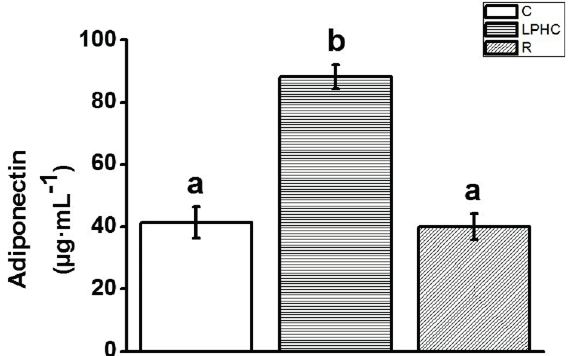
Figure 3 - Serum adiponectin levels in rats fed a control diet for 45 days (C ), a low-protein, high-carbohydrate (LPHC) 45 diet for 45 days or an LPHC diet for 15 days followed by a control diet for 30 days (R). Results are expressed as means ± standard errors of the means across eight animals per group. Statistical analysis was performed using ANOVA (one-way ANOVA, F = 8.65). Letters indicate significant differences among groups (p <